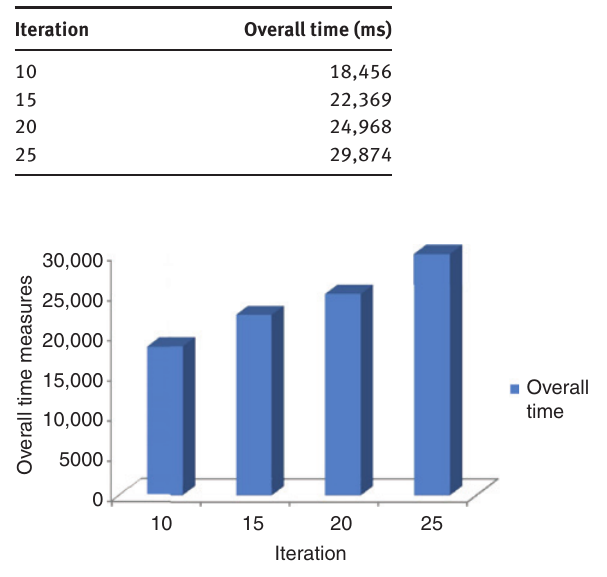
Figure 5: Graphical Representation for Overall Time Measures for Our Proposed